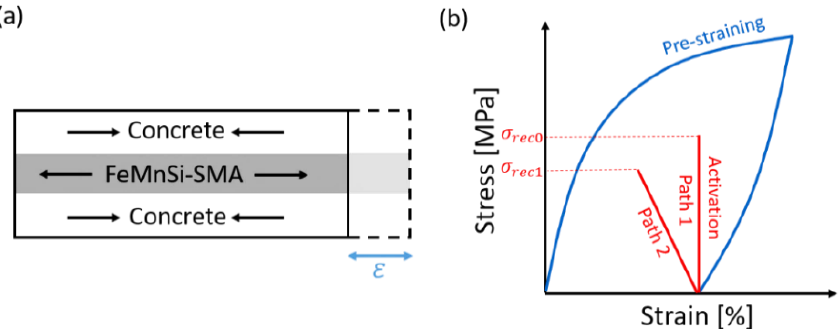
Figure 2. Schematic illustration of the interaction force between the concrete and the FeMnSi-SMA strip. ( a ) Example of activated FeMnSi-SMA material embedded into concrete, and ( b ) typical